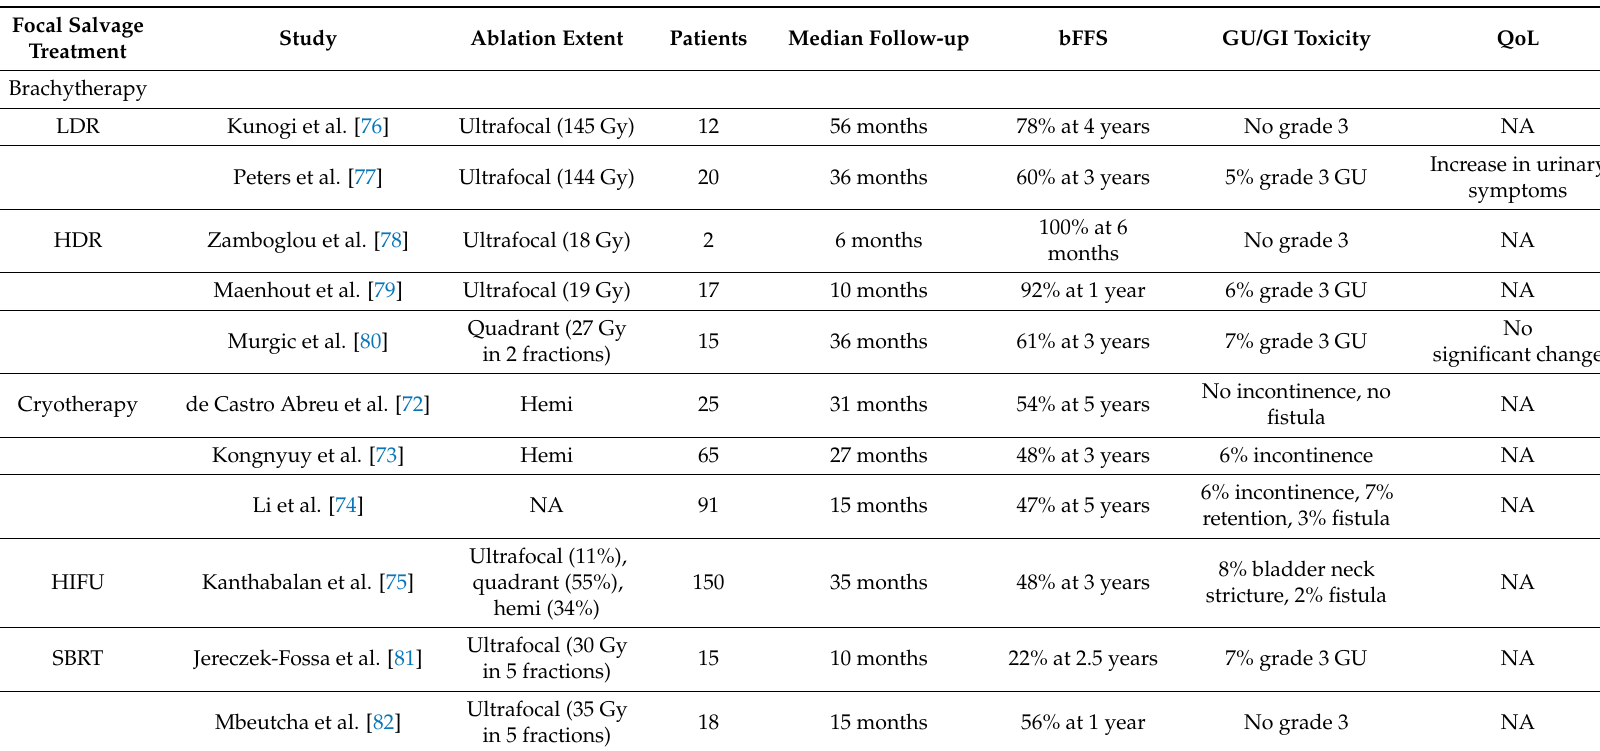
Table 1. Summary of studies on functional and oncologic outcomes of different focal salvage treatment modalities for localized radiorecurrent prostate cancer. Focal